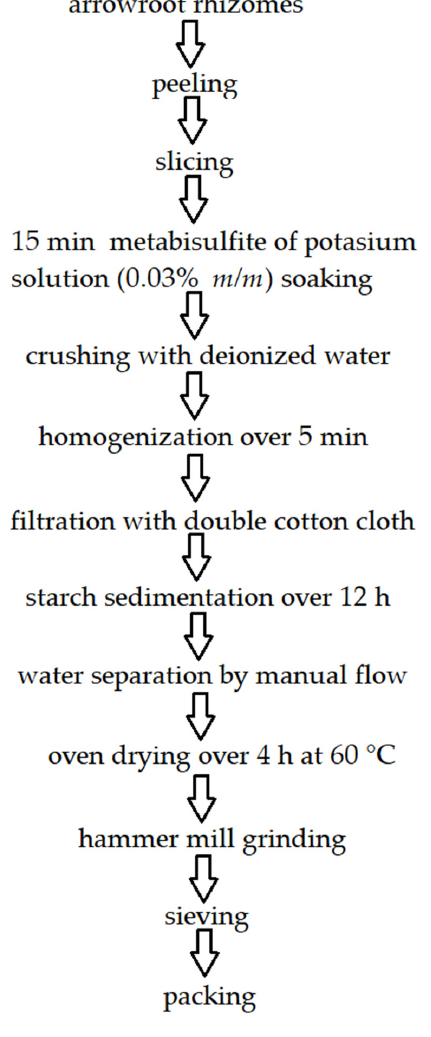
Figure 1. Arrowroot starch extraction. Own figure based on Ref. [29]. 2022, Tarique et al. The plant’s rhizome starch composition is presented in Tables 1 and 2. Table 1. Arrowroot rhizome starch composition. N/E—not evaluated.